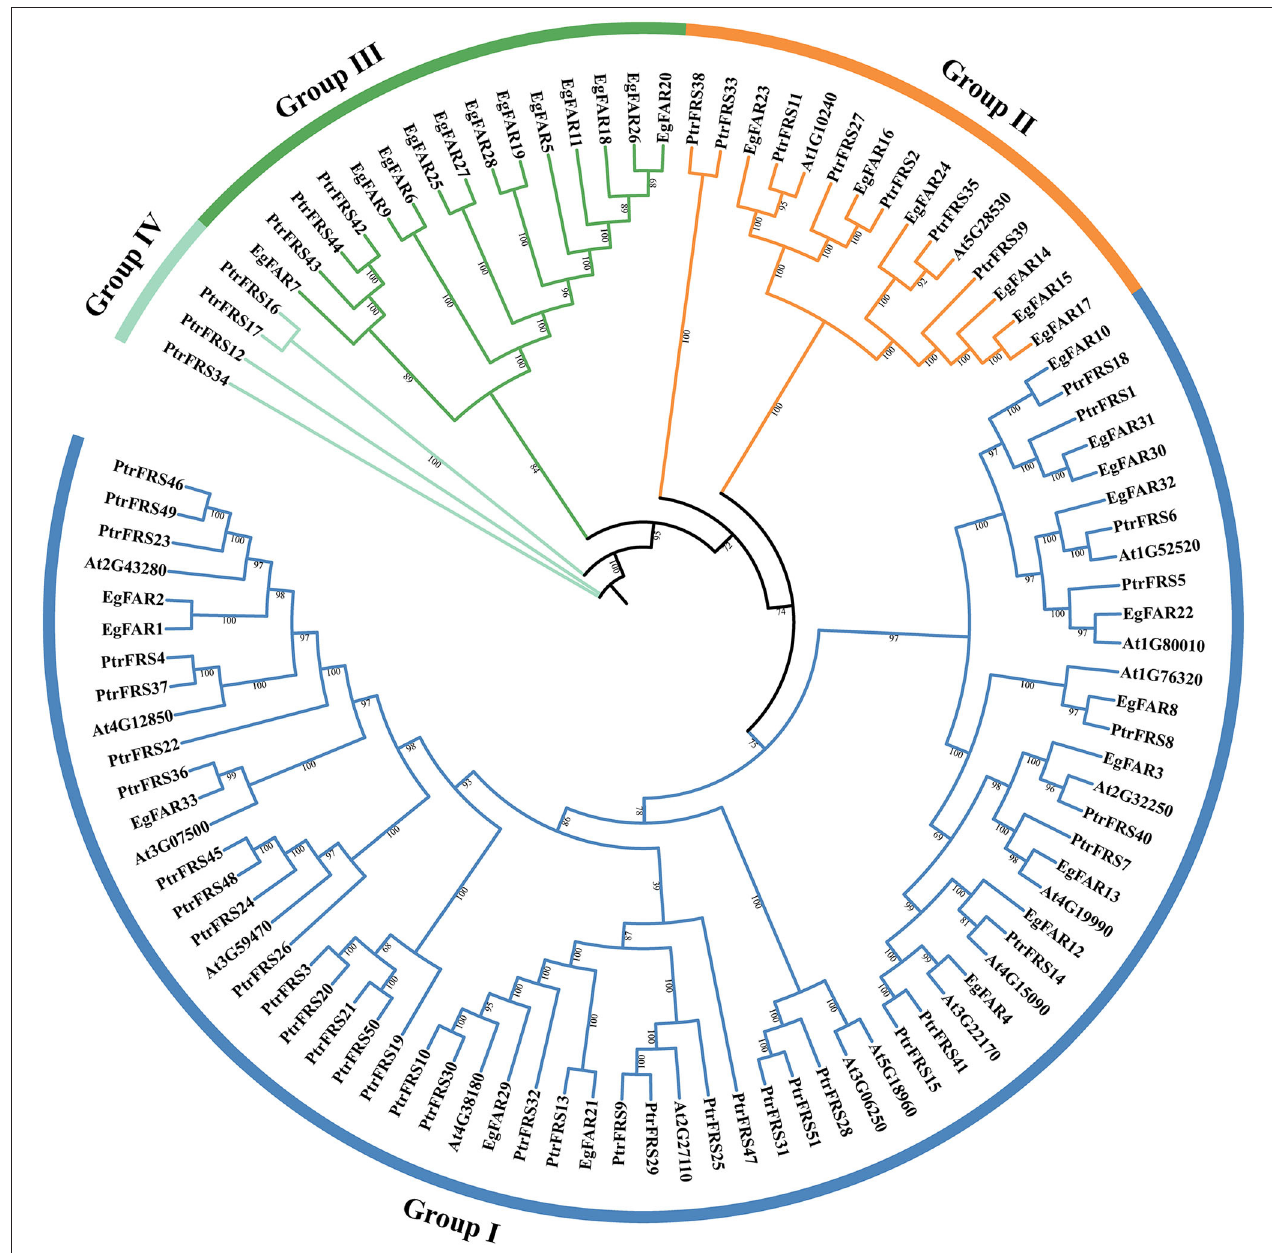
FIGURE 1 | Phylogenetic tree of FAR1/FHY3 protein sequences in Eucalyptus grandis , Arabidopsis , and poplar. The prefix “Eg,” “At,” and “Ptr” stand for E. grandis , Arabidopsis , and poplar, respectively. “Group I,” “Group II,” “Group III,” and “Group IV” were symbolized by blue, orange, green, and cyan colored arcs, respectively.